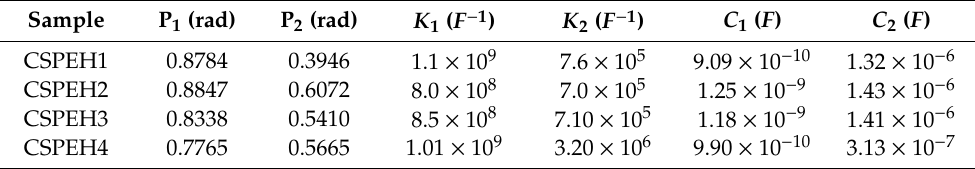
The electrical equivalent circuit (EEC) fitting parameters for electrolyte system at surrounding